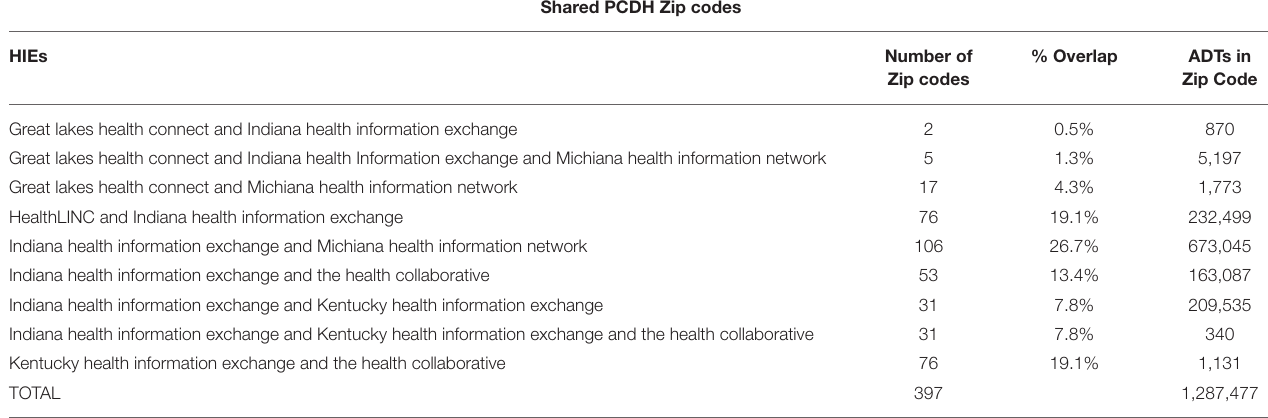
TABLE 2 | Shared zip code counts and ADT messages within that zip code in the